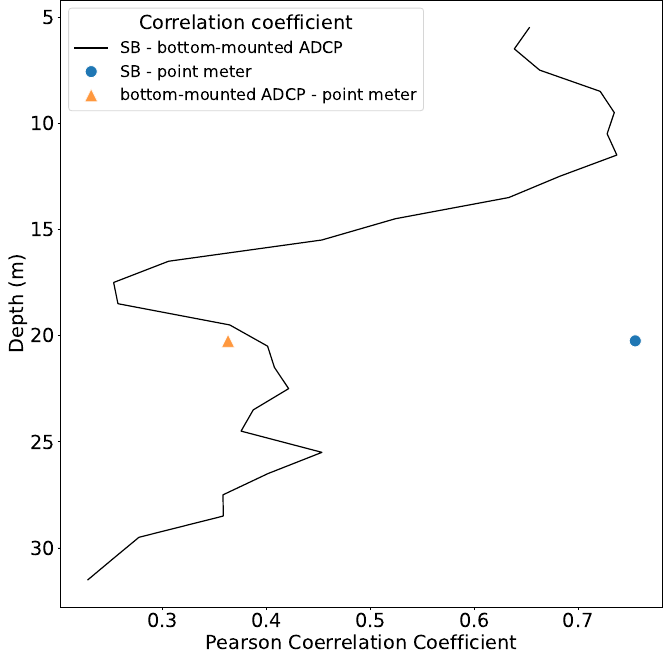
Figure 7. Depth profile of the Pearson correlation coefficient between the bottom-mounted and the SB profilers as well as the single-point current meter during stationary deployment in Fusafjorden.